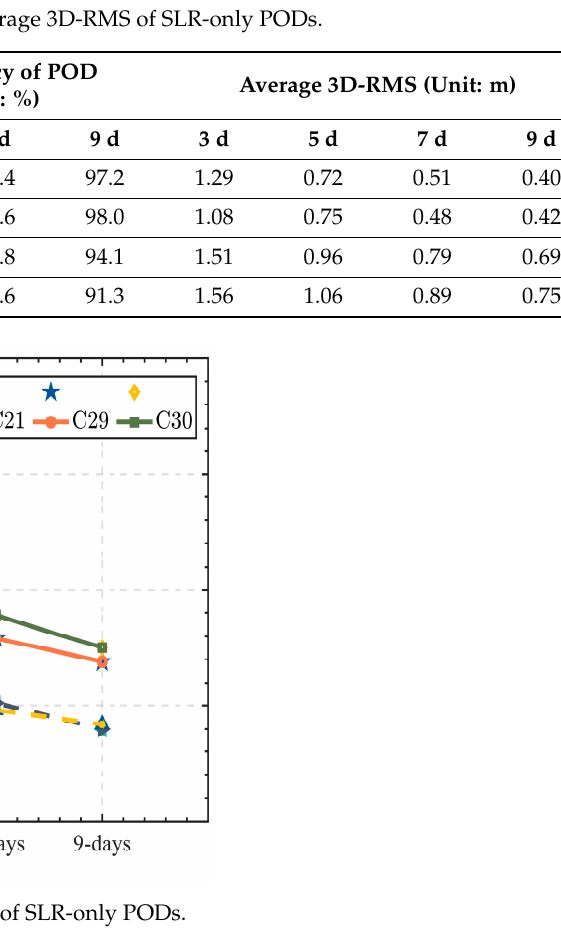
Table 6. The median RMS of 9-day solutions (Unit: cm). PRN